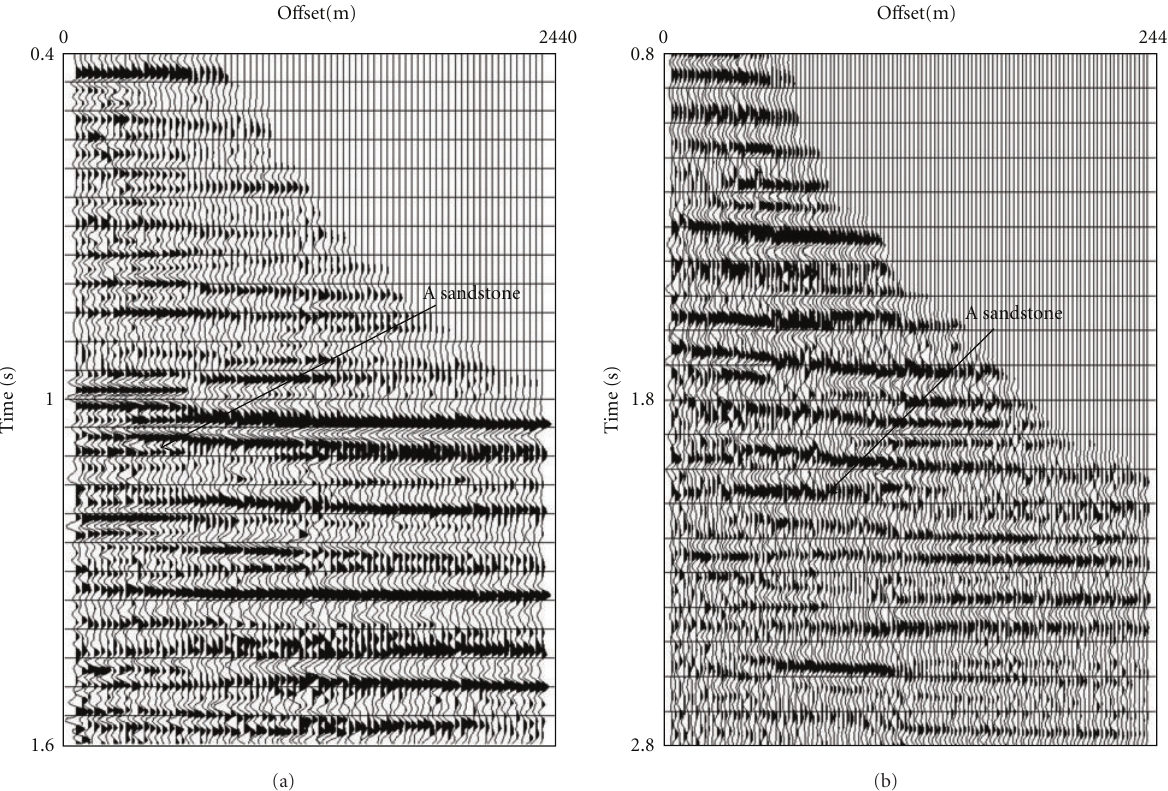
Figure 17: (a) P-wave gather shows a peak doublet at the top of Morrow A sandstone (1.07s) which changes to single peak at far o ff sets. (b) S1-wave gather shows a peak response at the top of Morrow A sandstone (2.08s) changing to trough with o ff set. The AVO response in real data P- and S1-wave gathers matches with the synthetic gather AVO response shown in Figures 12(b) and 13(b).